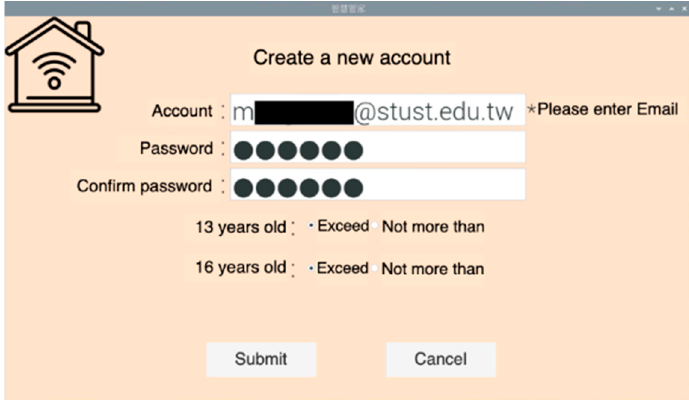
Figure 12. The interface of account establishment when the age is over 16.